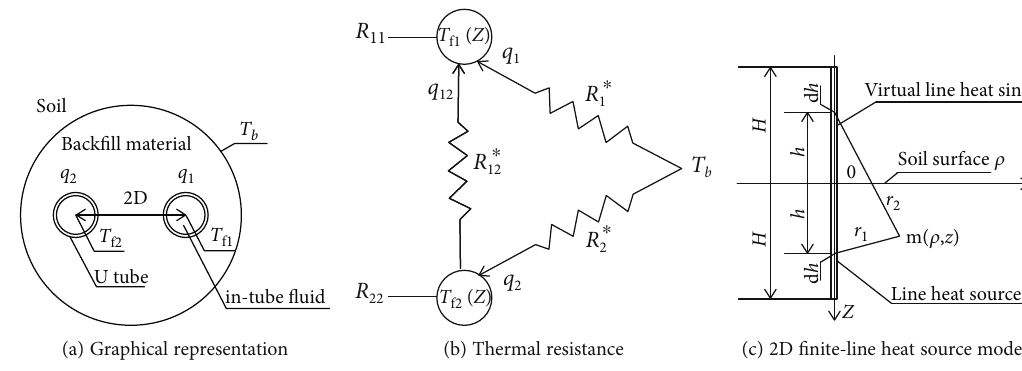
Figure 1: Heat transfer network of the